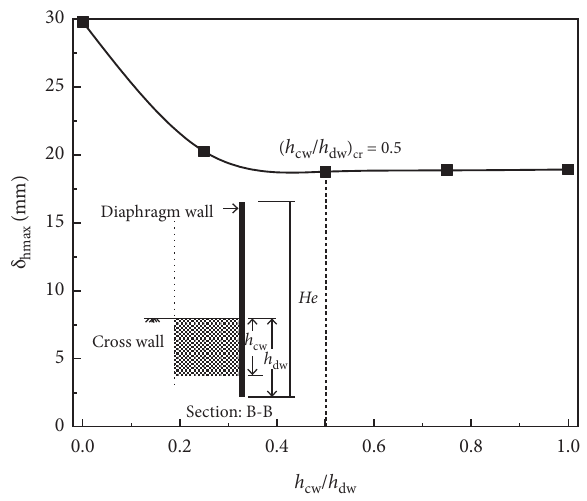
Figure 18: Relationship between PSR bedding depth.